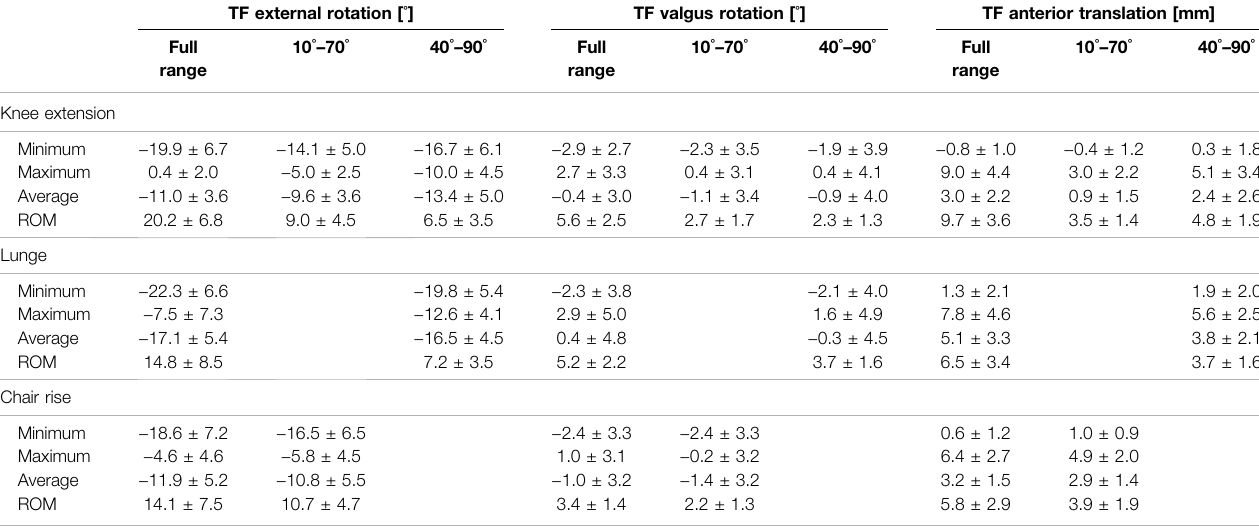
TABLE 1 | Minimum, maximum, average, and range of motion kinematics for the tibia relative to the femur during the knee extension, lunge, and chair rise. Kinematics is reported for the full range of knee fl exion, angle-matched fl exion range from 10 ° to 70 ° for comparison of knee extension to chair rise, and angle-matched fl exion range from 40 ° to 90 ° for comparison of knee extension to lunge.